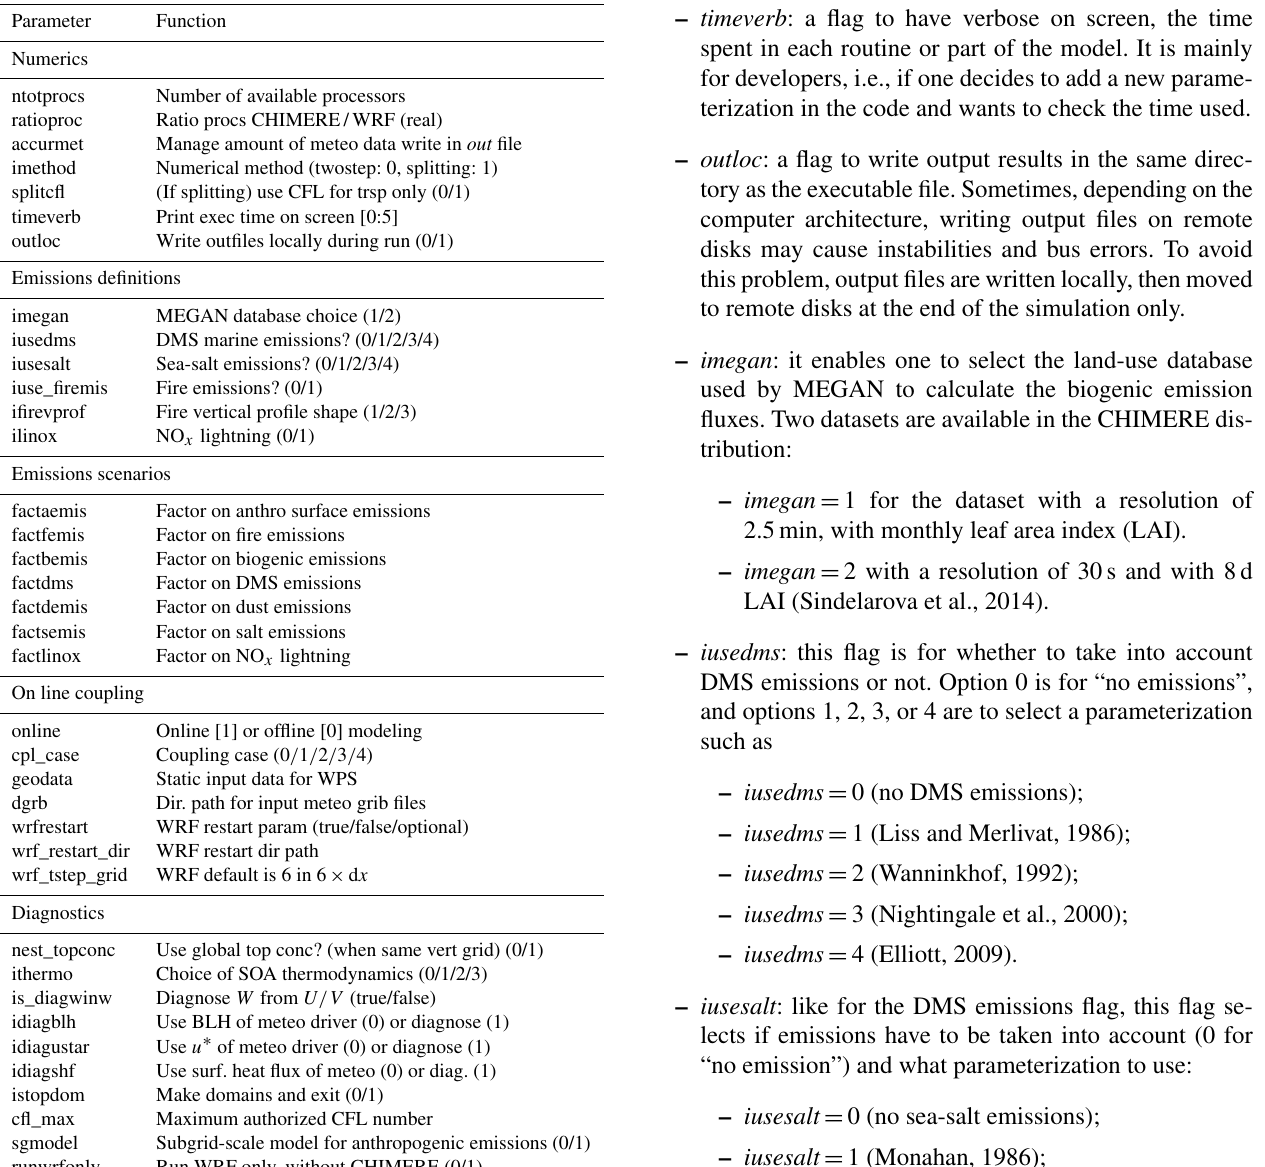
Table 1. List of the new parameters available for the users in this model version,